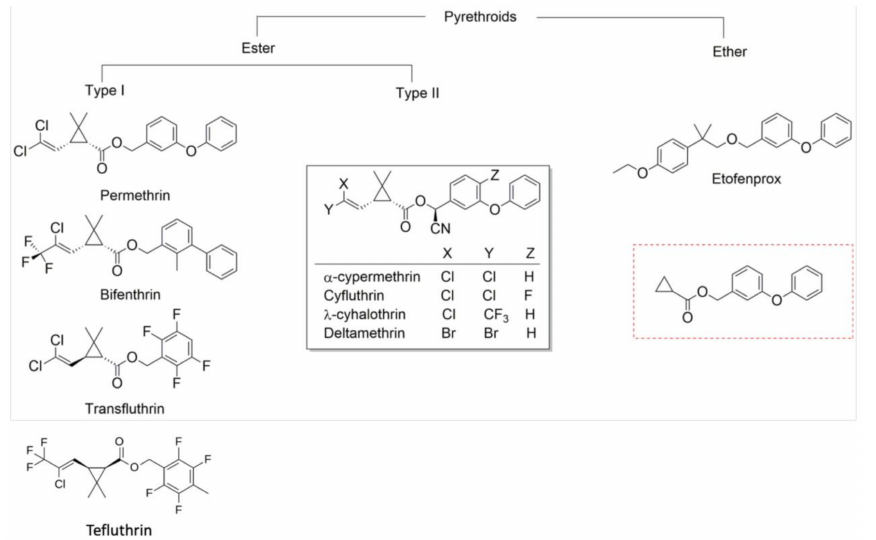
Figure 2. Chemical structure of pyrethroid insecticides used for malaria vector control. The common scaffold of pyrethroids, boxed in red, was identified by searching 230 million compounds available in the ZINC database (https://zinc.docking.org, accessed on 23 February 2020). Adapted from